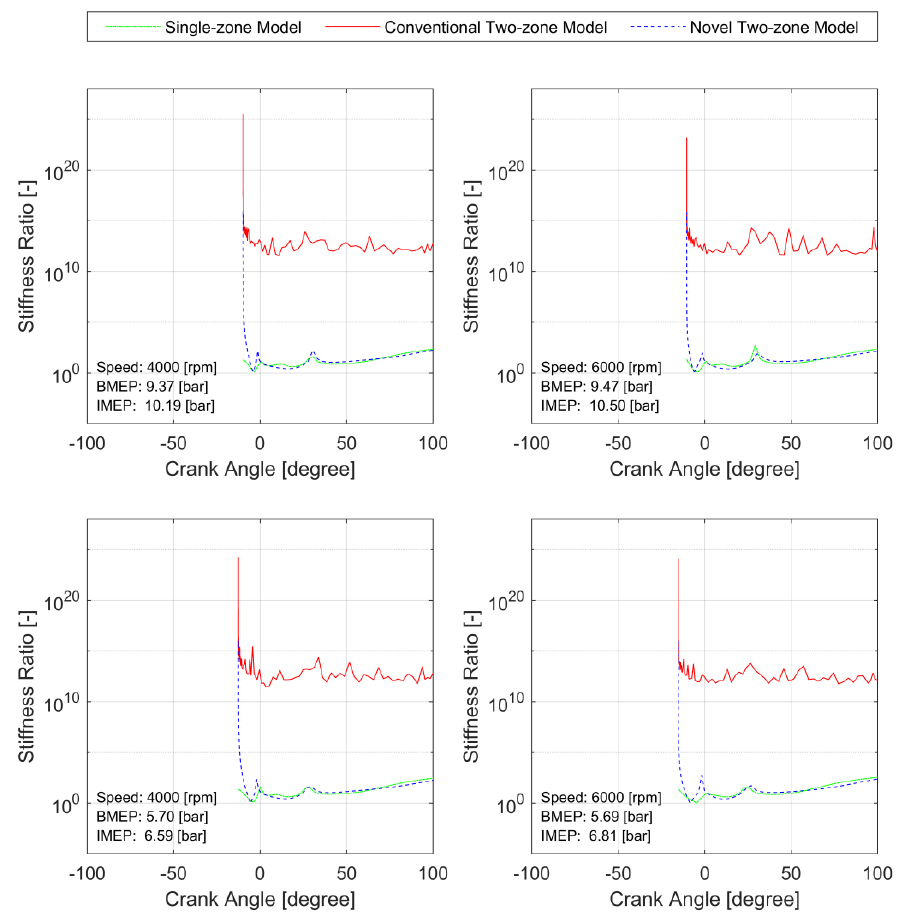
Figure 9. Sti ff ness Figure 9. Stiffness ratio.